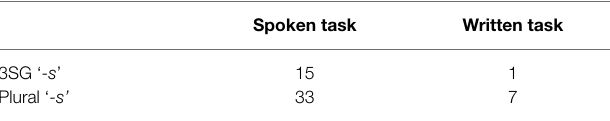
TABLE 8 | The comparison of the frequency of overgeneralization of 3SG ‘ -s ’ and plural ‘ -s ’ in the two tasks. Spoken task